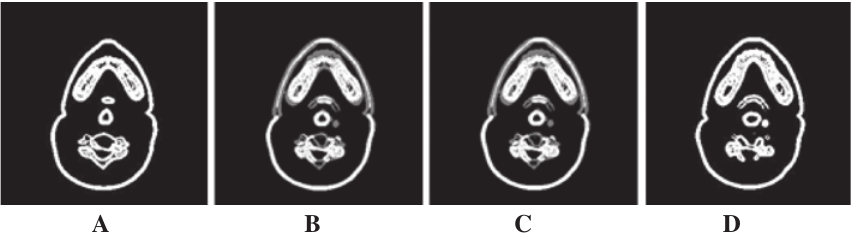
Figure 6: Re-creation of slices using MCR based interpolation. (B and C) are re-created slices by applying MCR based interpola- tion to the selected segmented slices (A and D).